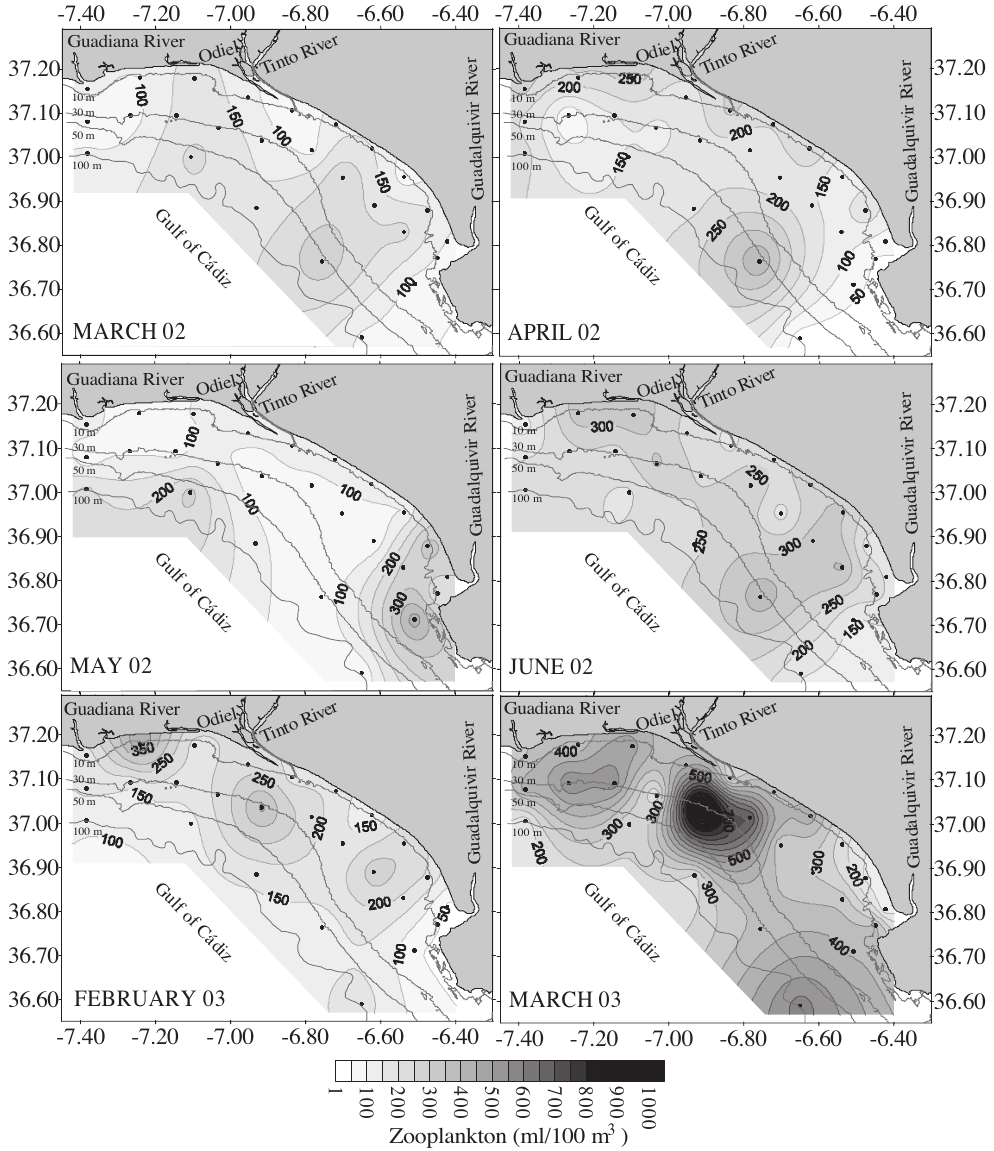
F IG . 5. – Horizontal distribution of zooplankton volume (ml/100 m 3 ) during the wedge sole main reproduction